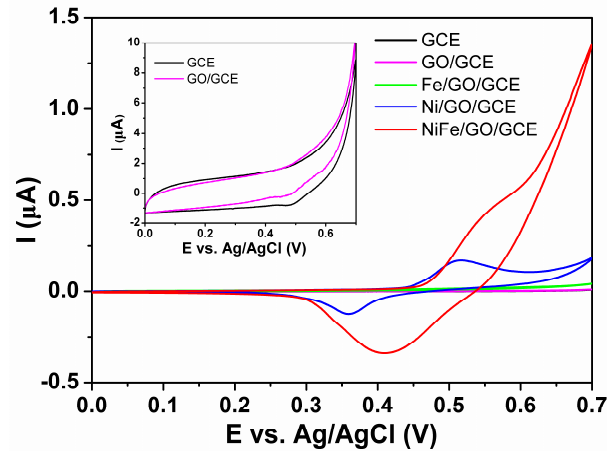
Figure 3. Cyclic voltammograms (CVs) of GCE, GO/GCE, Fe/GO/GCE, Ni/GO/GCE, and NiFe/GO/GCE in 0.1 M NaOH solution in the presence of 1.0 mM glucose at a scan rate of 10 mV/s. Inset: CVs of GCE and GO/GCE.